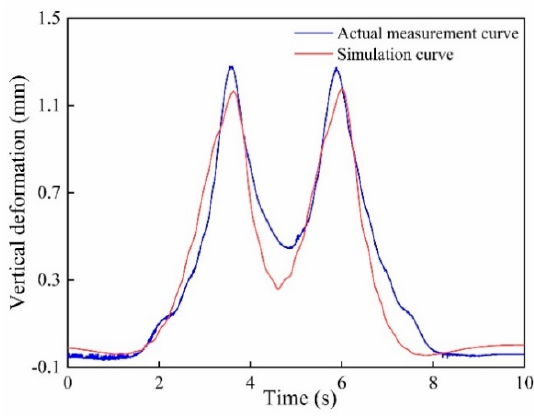
Figure 20. The simulation and experimental curves of the rail vertical deformation at 5 km/h.